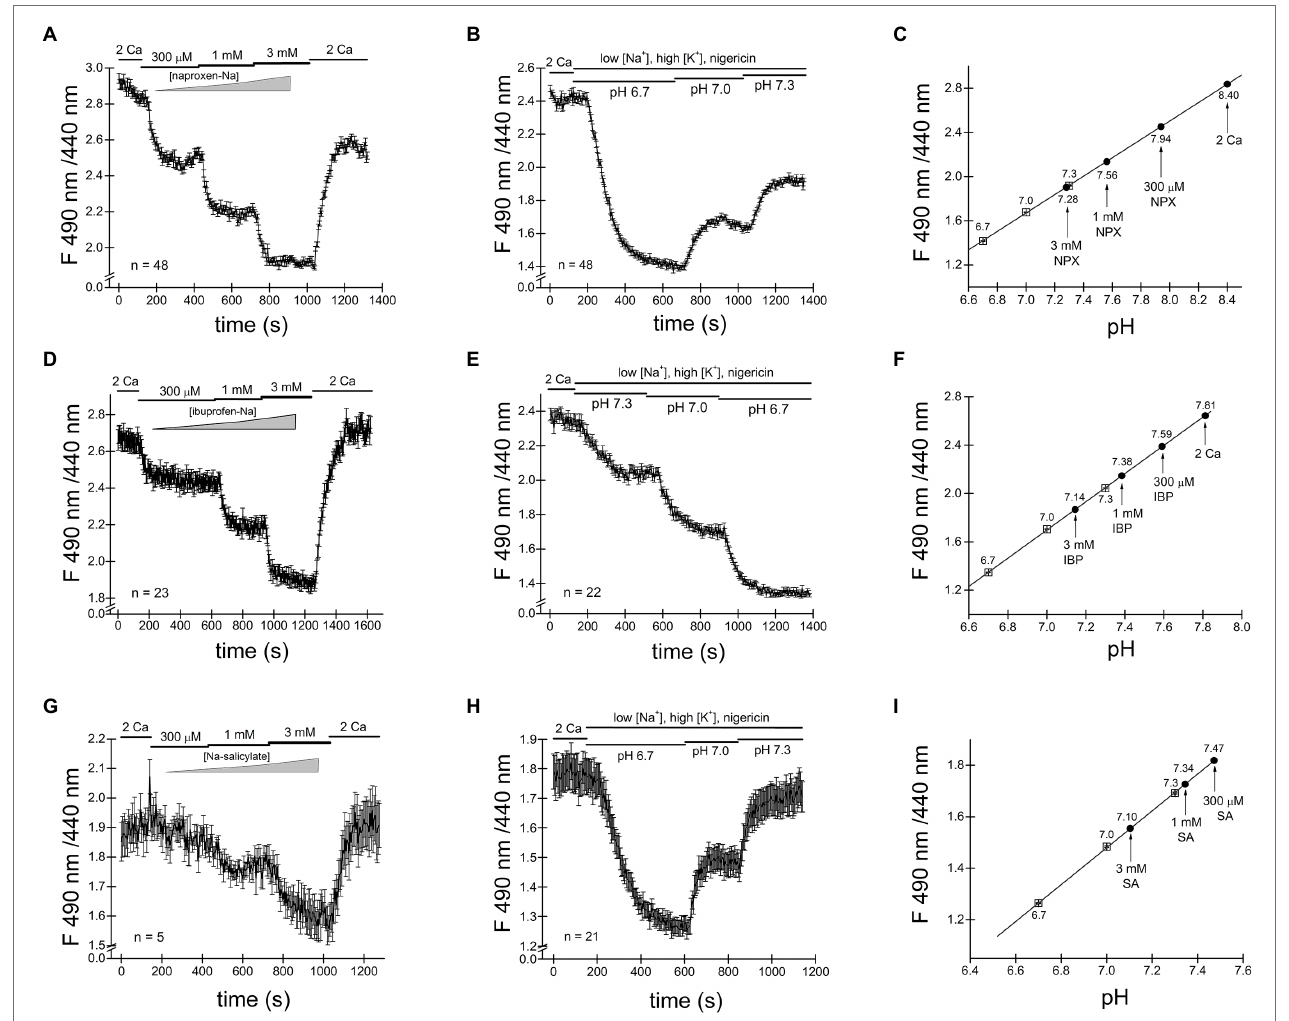
FIGURE 4 | Cytosolic acidification induced by naproxen, ibuprofen and salicylate. Fluorescence ratiometric pH measurements were performed in Jurkat T cells loaded with BCECF dye and superfused with the indicated concentrations of naproxen (A) . Naproxen-induced acidification was reversed upon washout (2 Ca bar). (B) Calibration experiment was performed by exposing the cells to low Na + /high K + solution containing 5 μ M nigericin at three different extracellular pH values (6.7, 7.0, and 7.3). (C) Calibration curve constructed from measurement means taken at steady state in (B) . The line is a linear fit. Mean steady state fluorescence ratios in the presence of naproxen from ( A ; indicated by vertical arrows) are superimposed on the calibration curve to determine the corresponding cellular pH. (D,G) Ratiometric BCECF measurements for ibuprofen and salicylate were performed as in (A–C) . Ibuprofen and salicylate dose-dependently and reversibly acidified the Jurkat T cell cytoplasm. Data points in (A,B,D,E,G,H) represent means±SEM obtained from measurements performed in groups of cells. (F,I) Calibration curves generated from (D,E) , and (G,H) , respectively, as in (C)